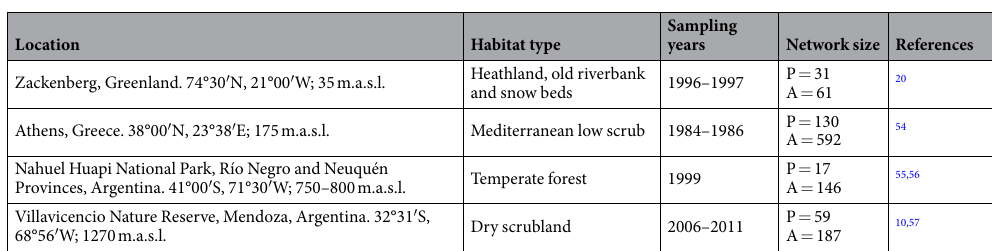
Table 1. Basic information of the empirical networks used in this study. P/A indicates number of plant/animal species in the